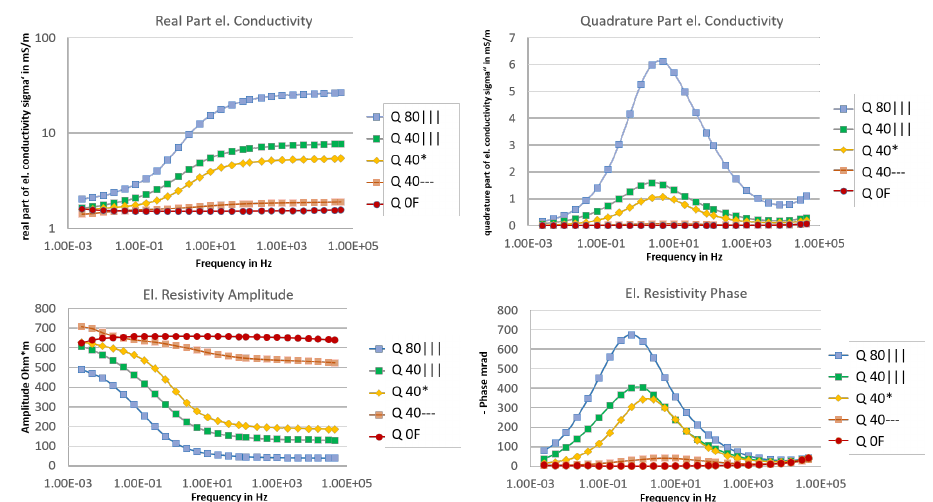
Figure 8. Spectral Induced Polarization spectra of steel fiber reinforced concrete samples Q80 ||| Cylinder, Q40 ||| Cylinder, Q40* Cylinder, Q40—Cylinder and Q0F Cylinder. Real and quadrature parts of electrical conductivity ( top ) and resistivity amplitudes and phases ( bottom